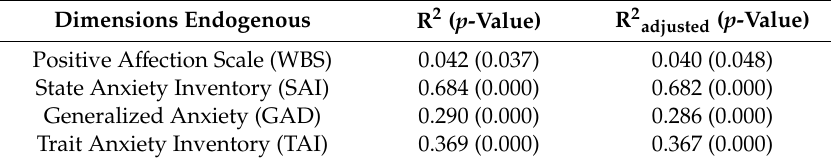
Table 11. R 2 and R 2 adjustment coe ffi cient, adjusted for the PANAS-GAD-7-IDATE model. Dimensions